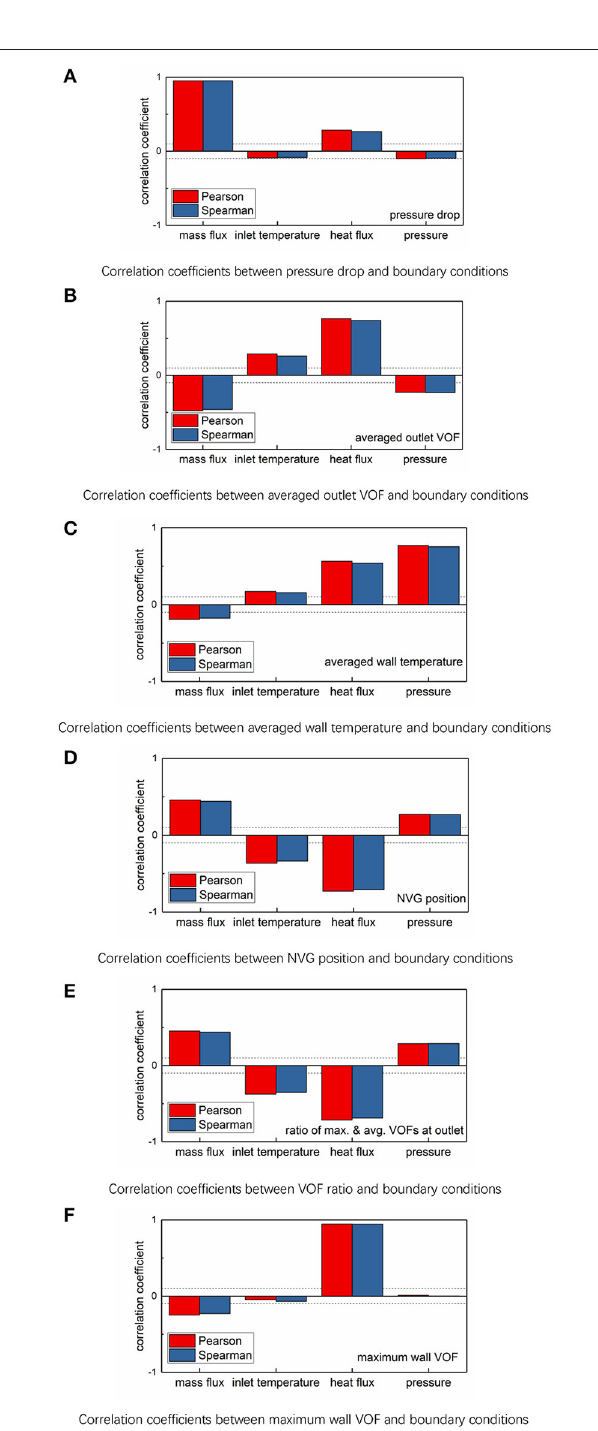
FIGURE 7 | Correlation coefficients between boundary conditions and outputs. (A) Correlation coefficients between pressure drop and boundary conditions. (B) Correlation coefficients between averaged outlet VOF and boundary conditions. (C) Correlation coefficients between averaged wall temperature and boundary conditions. (D) Correlation coefficients between NVG position and boundary conditions. (E) Correlation coefficients between VOF ratio and boundary conditions. (F) Correlation coefficients between maximum wall VOF and boundary